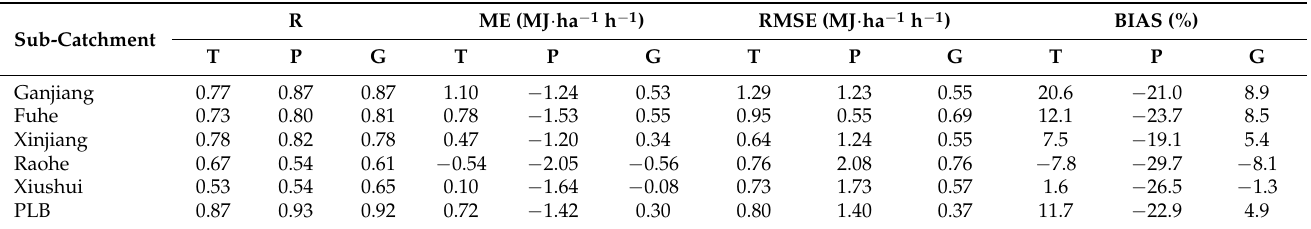
Table 4. Performance comparison of the three SPPs for erosivity density at different